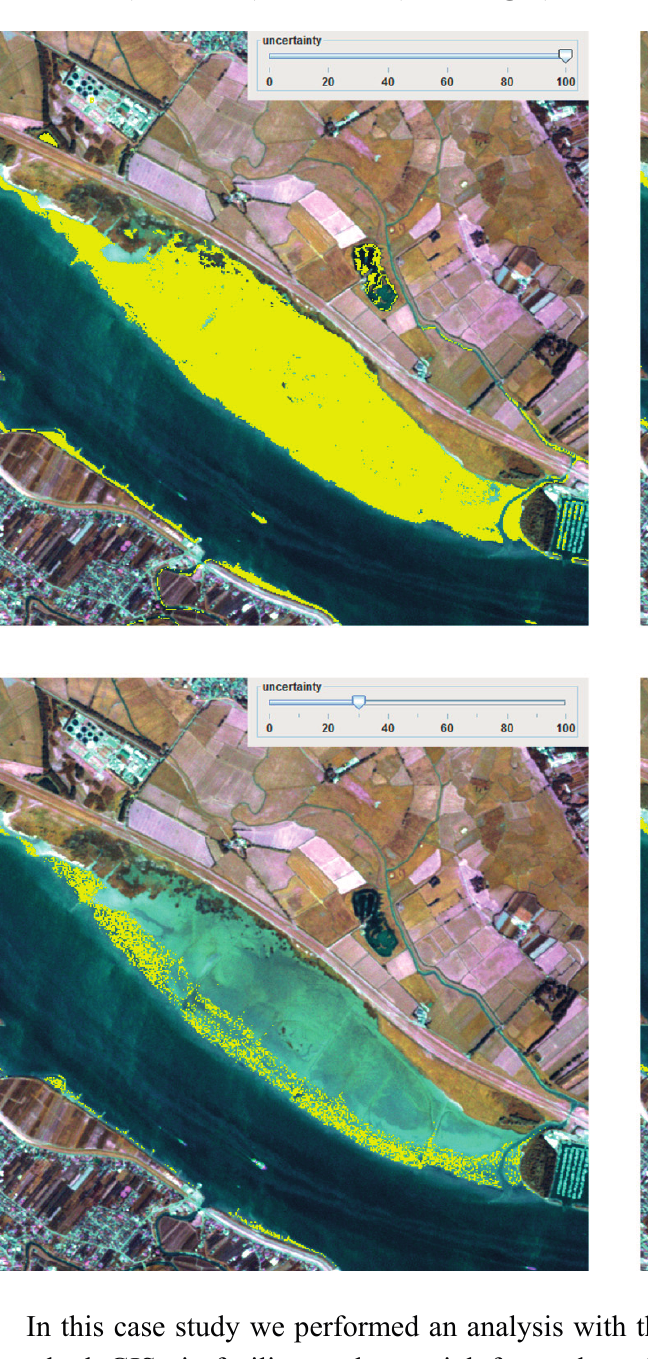
Figure 11. Iterative filtering of change by 100% ( upper left ), 50% ( upper right ), 30% ( lower left ), and 40% ( lower right )